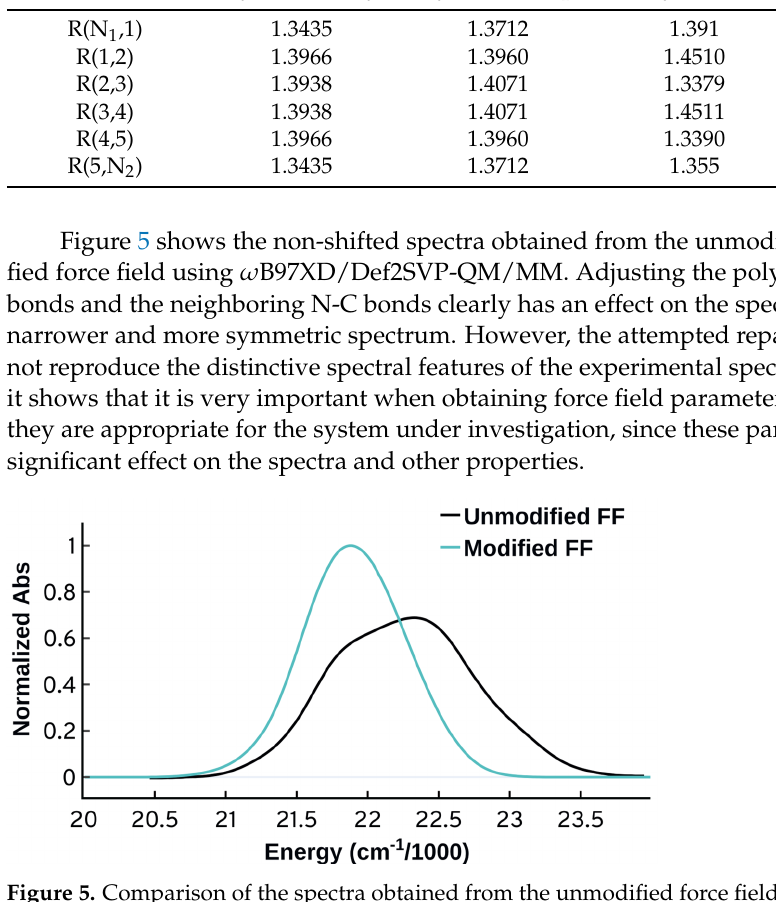
Figure 5. Comparison of the spectra obtained from the unmodified force field [46] (unmodified FF) and after adjusting the polymethine bond length using parameters obtained from ω B97XD/Def2SVP Cy3 optimized structure. Spectra are normalized relative to the modified